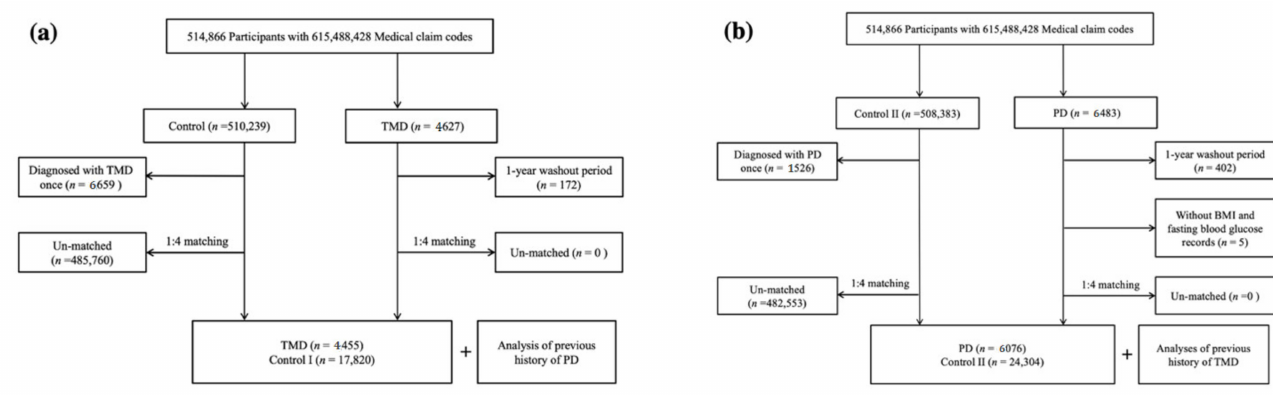
Figure 1. A schematic illustration of the participant selection process: ( a ) TMD in PD; ( b ) PD in TMD. TMD, temporo- mandibular joint disorder; PD, Parkinson’s